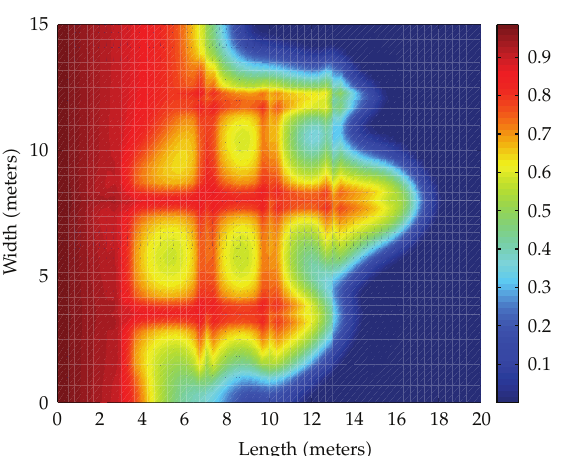
Figure 9: Water saturation profile at 0.5 PVI by the conventional method: Example 3.